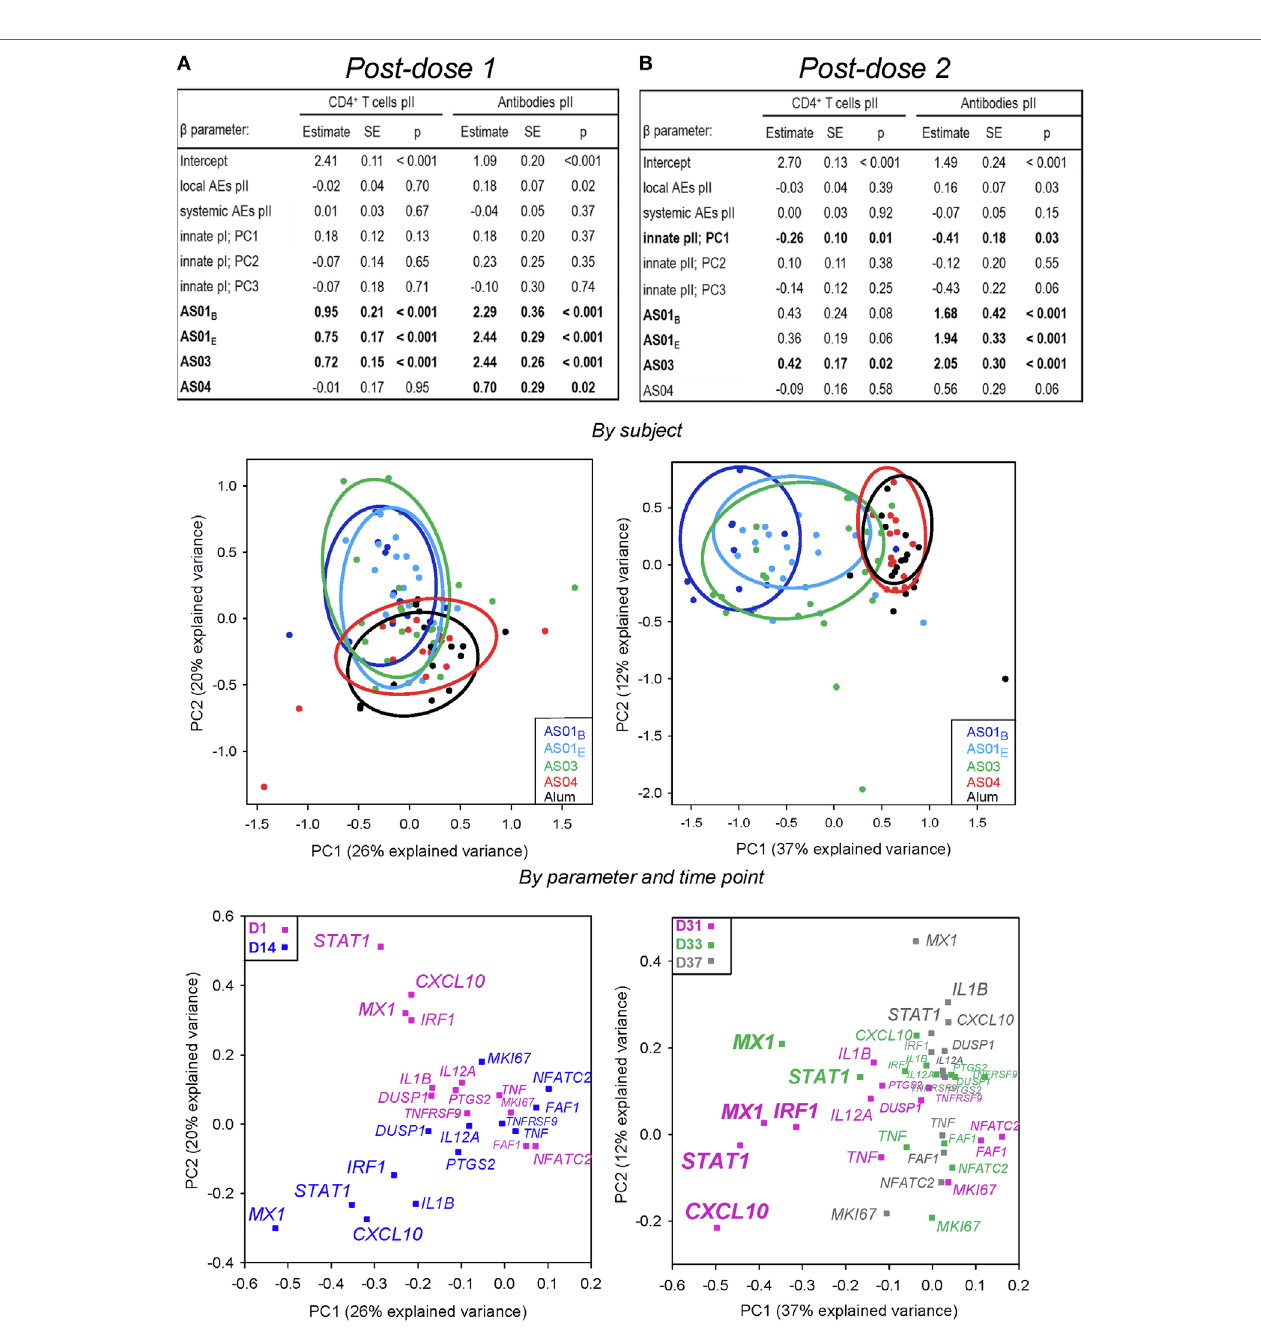
FiGUrE 6 | Associations between the adaptive responses, and both the innate mRNA responses and reactogenicity. As for Figure 4 , for gene expression in the AS01 B , AS01 E , AS03, AS04, or Alum groups ( N = 11, 18, 23, 15, and 17, respectively). Results show data obtained after the first (a) or second (b) injection. Upper panels: multi-parametric analysis of the adaptive response to vaccination was performed for each coefficient ( β ) of the listed model input parameters, in terms of the estimate of the effect size, standard error (SE), and p -value ( p ). Input parameters included the local and systemic reactogenicity scores calculated from the respective solicited adverse events (AEs) post-dose 2 and innate responses after each dose. Intercept, β for Alum group ( β 0 ). Adjuvant systems (AS) groups were compared with the Alum group (considered as baseline). HBs-specific CD4 + T-cell and antibody responses were measured at 2 weeks post-dose 2. PCs that were significantly associated ( p < 0.05) with adaptive responses are indicated by bold font. Middle panels: principal component (PC) analysis of post-vaccination innate responses was performed by subject. The variance explained by the first three PCs was 55% post-dose 1 and 59% post-dose 2. Each dot represents the expression profile of an individual subject. Aggregation of the subjects into treatment groups is arbitrarily visualized by the colored ellipses, according to the color coding shown in the left-hand corners of the plots. The PC1 accounted for 26 and 37% of the variance after the first and second dose, respectively, and is plotted against the PC showing the strongest association with adaptive responses in the tables shown in the upper panels, i.e., the PC2 after each dose. Lower panels: as for the middle panels, but with the PCs representing the variables at the post-vaccination time-points indicated by the color coding in the upper corners of the plots. An overview of the PC plots by variable/time-point for each PC1, PC2, PC3 combination is presented in Figure S4 in Supplementary Material.